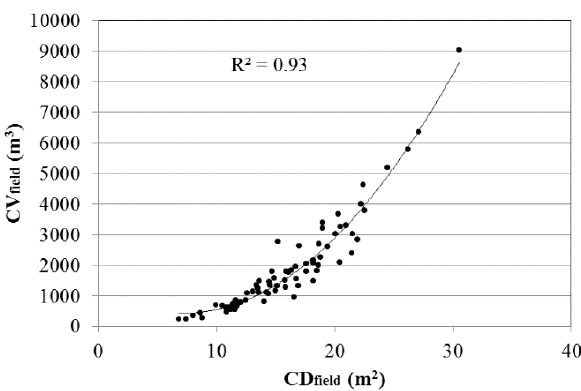
Figure 7. Scatterplot between canopy volume (CV field ), calculated using Equation (1), and measured crown diameter (CD field ). The solid curve is the best-fit, polynomial regression equation.